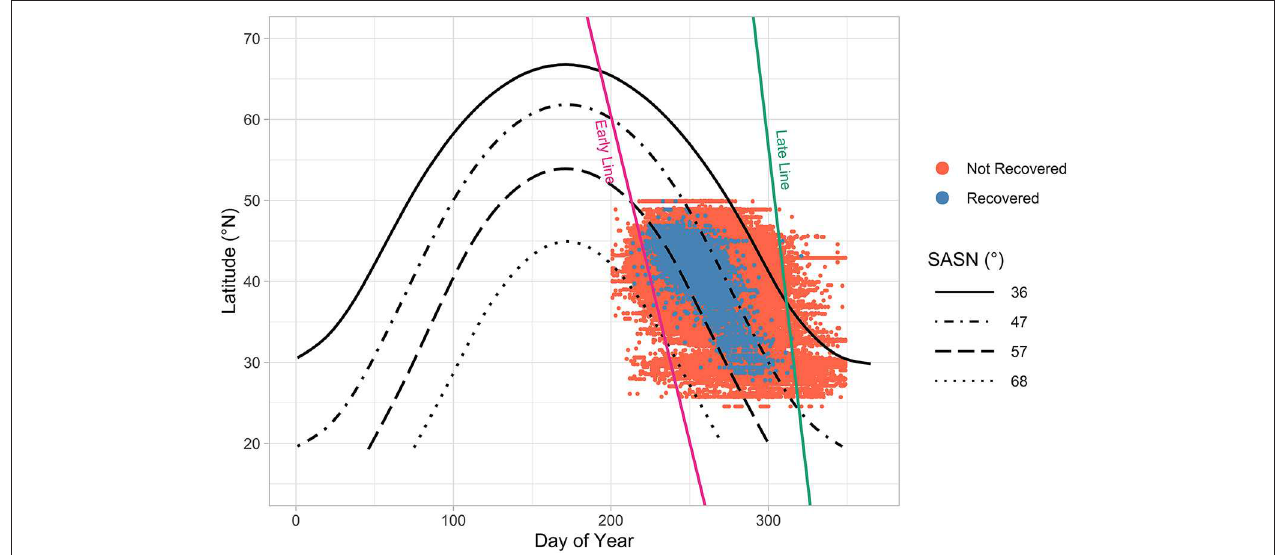
FIGURE 6 | Distribution of tagging locations of monarchs, which extends beyond Monarch Watch’s official tagging timeframe, by latitude and day-of-year (DOY 200–350, 19 July to 16 December, n = 1,411,214). Isoclines illustrate approximate limit of monarchs recovered (blue dots) (57 ◦ –47 ◦ ) and not-recovered (red dots) (68 ◦ –36 ◦ ) in the MBBR. Pink and green lines represent authors’ estimates of the demarcation dates and locations separating monarchs that are migrating to Mexico from those that are of the previous breeding generation (left of the pink line), and butterflies with little chance of reaching the MBBR (right of the green line). Pink (early) line stretches from 1 August at 50 ◦ N latitude to 1 September at 25 ◦ N. Green (late) line stretches from 31 October at 50 ◦ N to 15 November at 25 ◦ N. Note the handful of recovered butterflies tagged left of the pink line-they may represent recently emerged monarchs tagged while “staging” before the start of the migration. Also note two recoveries to the right of the green line and the 36 ◦ SASN isocline-both may be the result of tag code or other errors, since each was tagged in November > 30 days after the last recovery for their respective latitudes. Analyses were limited to the area between the pink and green lines ( n =